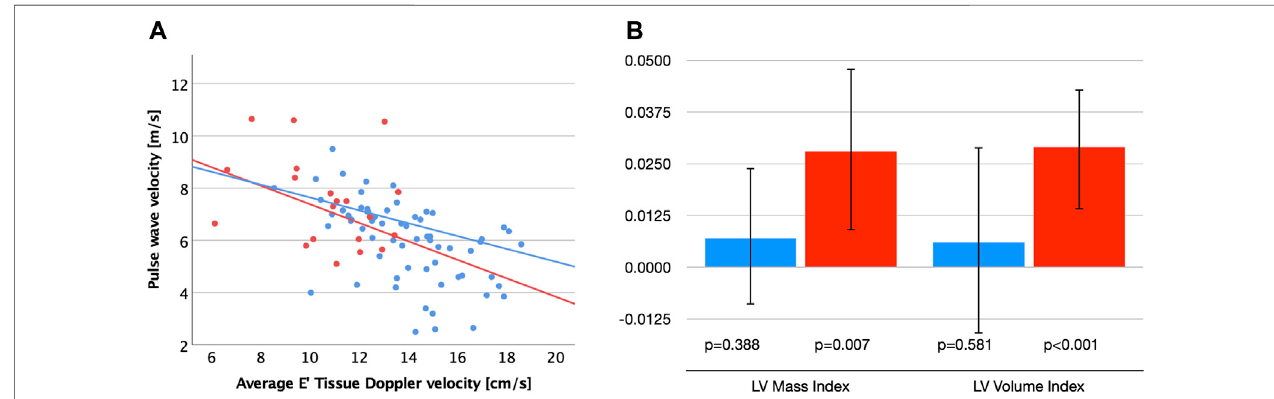
FIGURE 1 | (A) Scatter plot visualizing correlations between carotid-femoral pulse wave velocity (cfPWV) and diastolic function (E ′ ) for patients with MFS (red dots andregressionline)andhealthycontrols(bluedotsandregressionline). (B) UnstandardizedB-coef fi cientsforassociationsbetweencfPWVwithleftventricular(LV)mass and volume index corrected for age and sex. Error bars indicate 95% con fi dence intervals. MFS (red), Control group (blue).